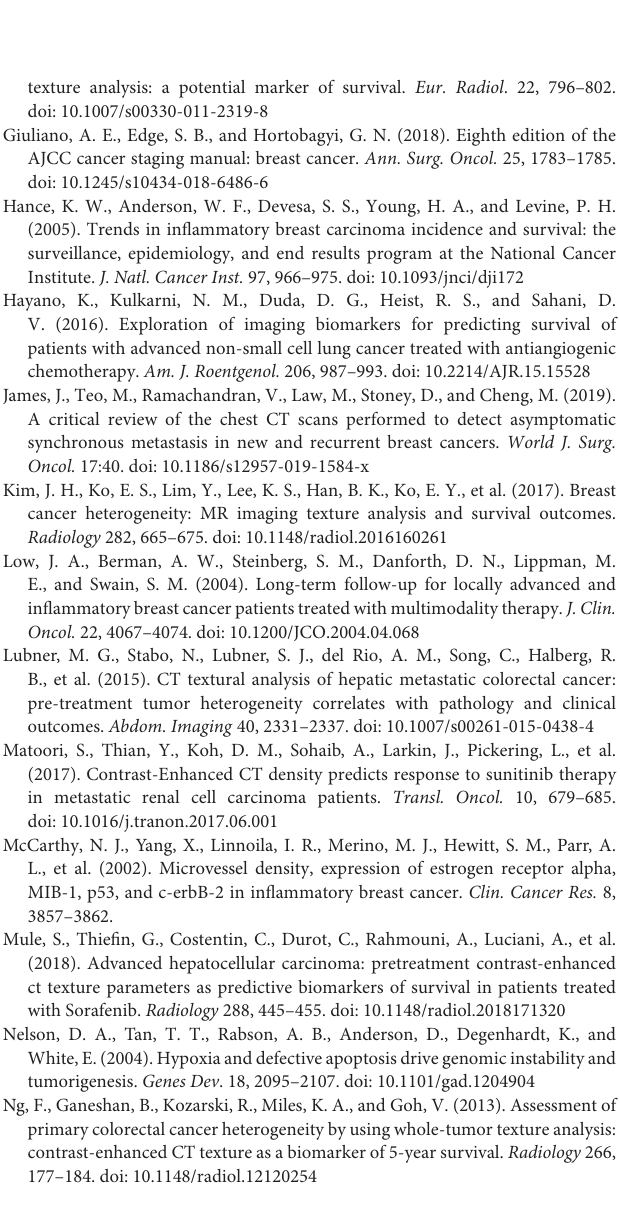
Supplementary Figure 1 | Receiver operating characteristic (ROC) curve analyses for the optimal cutoff values. An ROC curve (an area under the curve [AUC], 0.67; P = 0.004) for mean attenuation (A) , an ROC curve (AUC, 0.63; P = 0.024) for SD (B) , an ROC curve (AUC, 0.69; P = 0.001) for MPP (C) , and an ROC curve (AUC, 0.62; P = 0.042) for entropy (D) . Supplementary Figure 2 | Kaplan–Meier curves of the M stage. There were significant differences in overall survival according to the metastasis (M1) stage at the time of the diagnosis. Supplementary Table 1 | CT texture features at spatial scale filters of 2–6. Supplementary Table 2 | Spearman rank correlation coefficients for CT texture